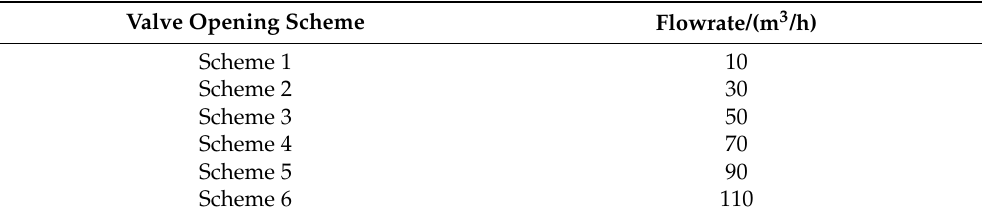
Table 2. The upstream and downstream pressure of the closing valve.